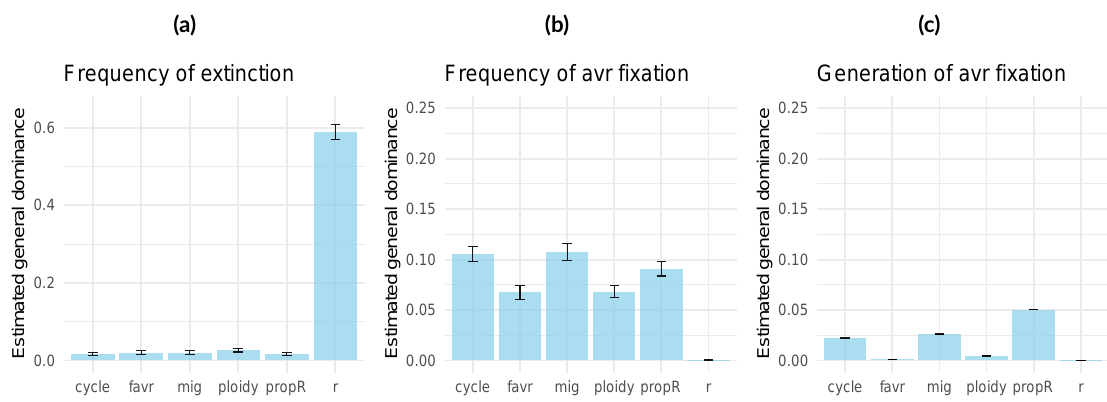
Figure 3 – Estimated general dominance of each predictor calculated from general linear models applied to three output variables of the random simulation design: the frequency of extinction of population, the frequency of fixation of the avr allele among replicates with surviving populations, and the generation of fixation of the avr allele. For each pre- dictor the general dominance was estimated from bootstrap average values with the corresponding standard error for 100 bootstrap